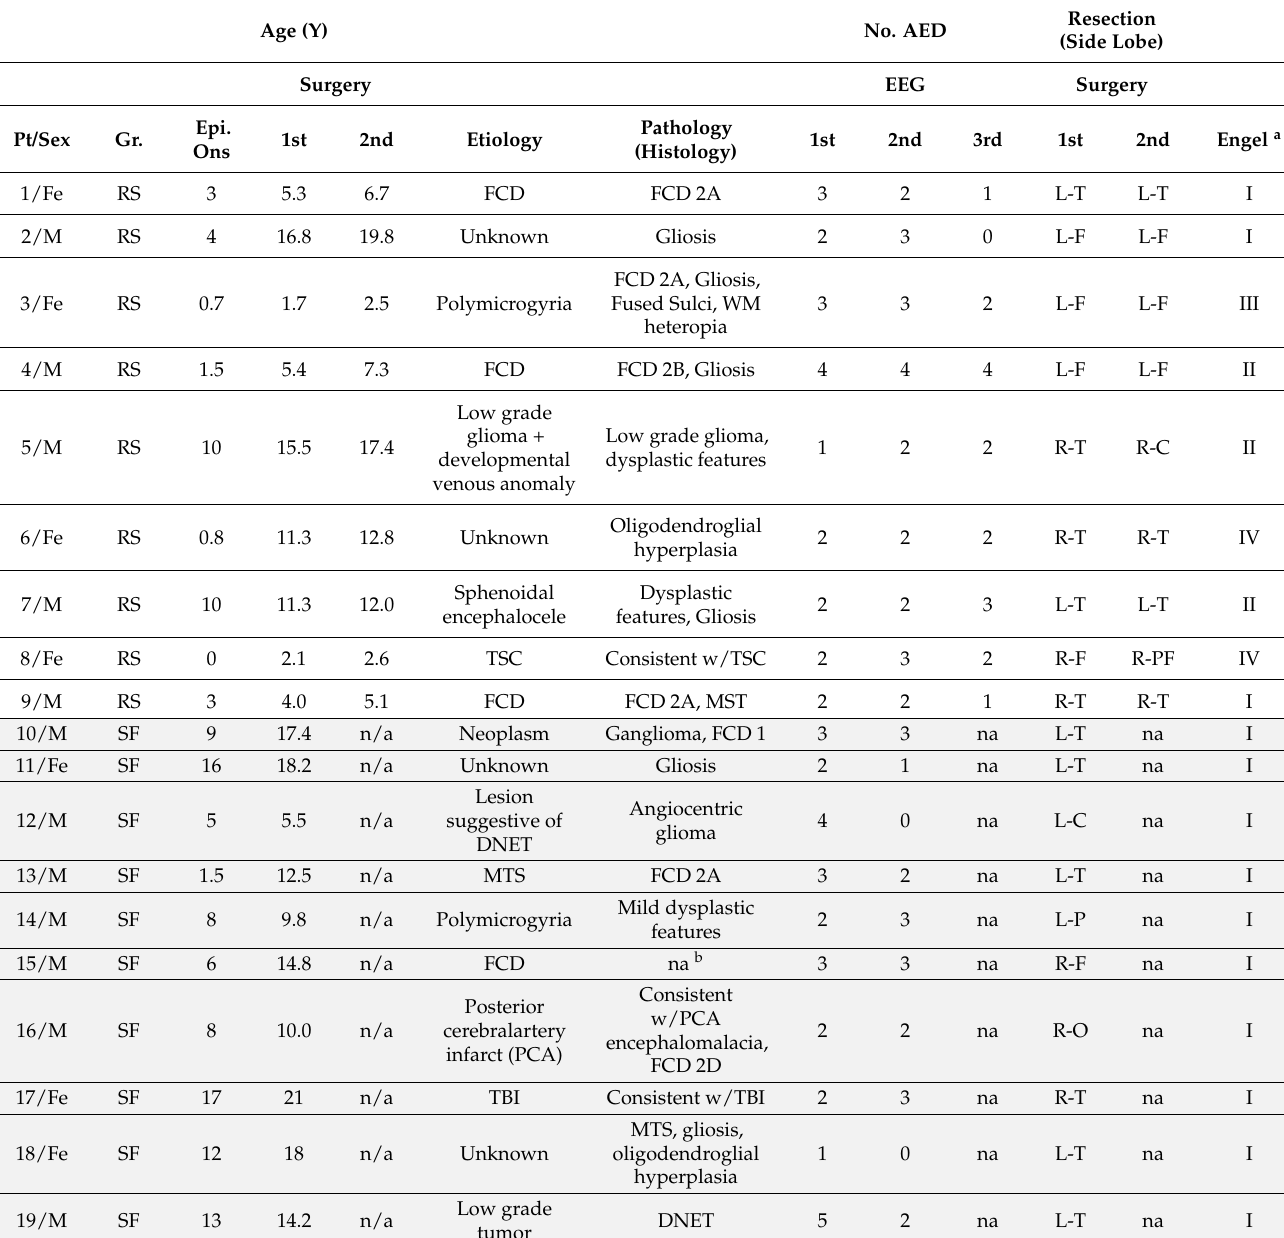
Table 1. Clinical characteristics of our